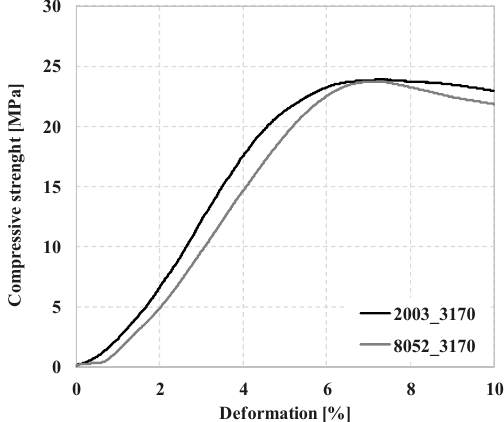
Figure 12. Compression strength deformation diagram in the case of 2003_3170 and 8052_3170 recipes.